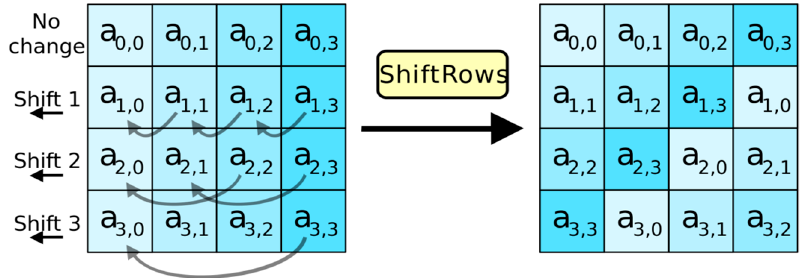
Figure 3. Steps of the Shift Row.